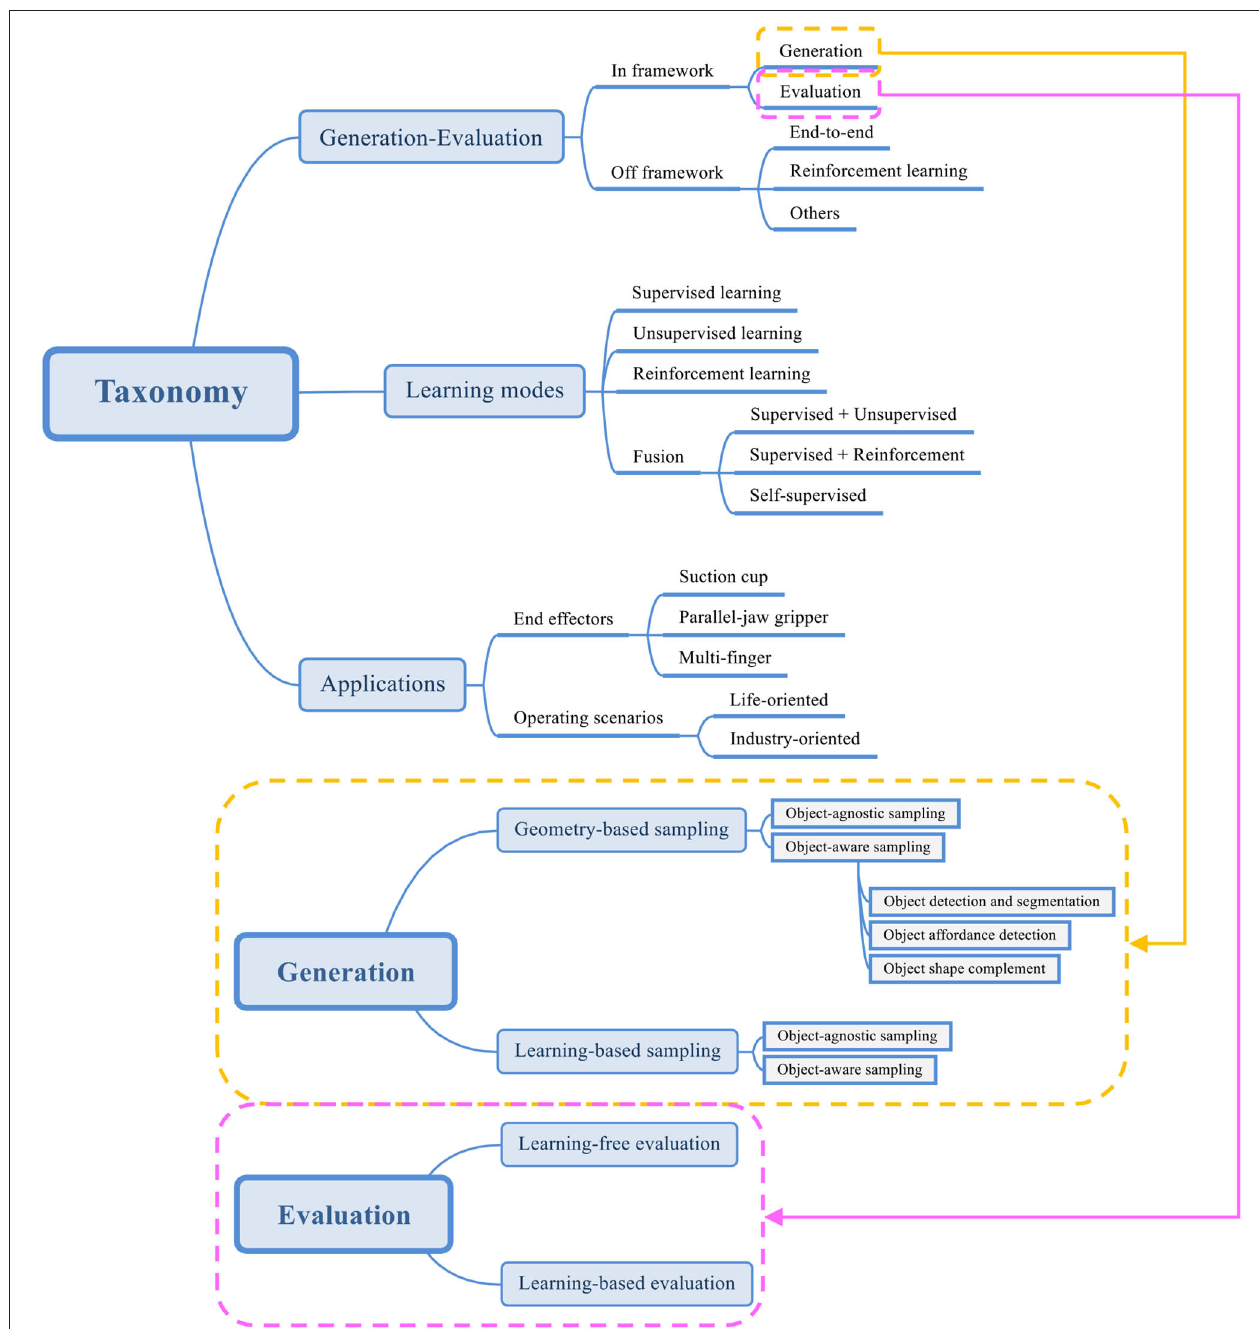
FIGURE 2 | Robotics dexterous grasping methods based on point cloud and deep learning.